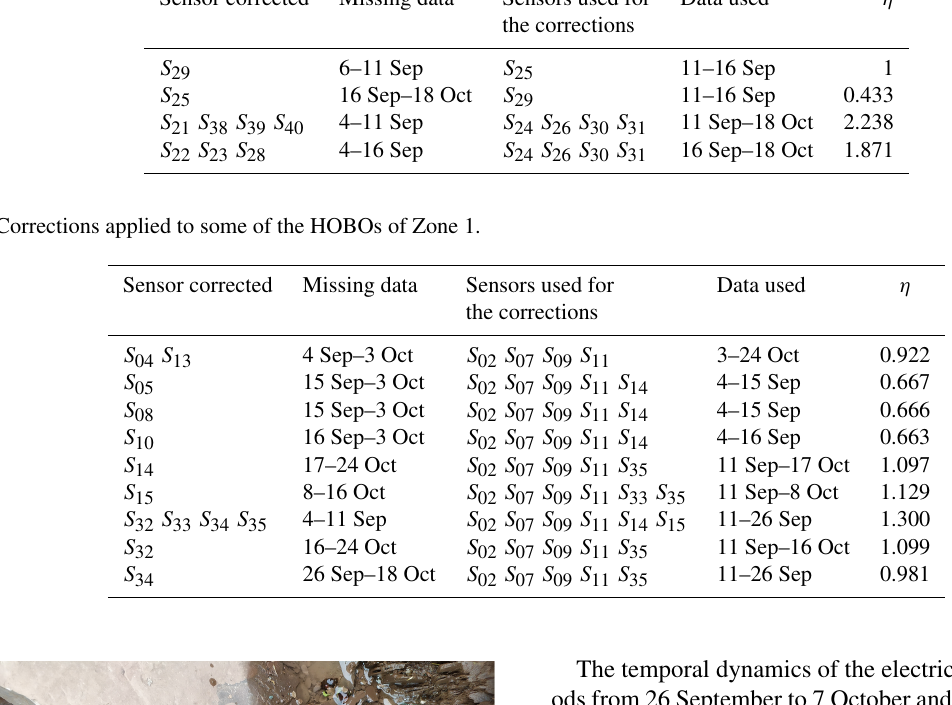
Table B1. Corrections applied to some of the HOBOs of Zone 2. Sensor corrected Missing data Sensors used for Data used η the corrections